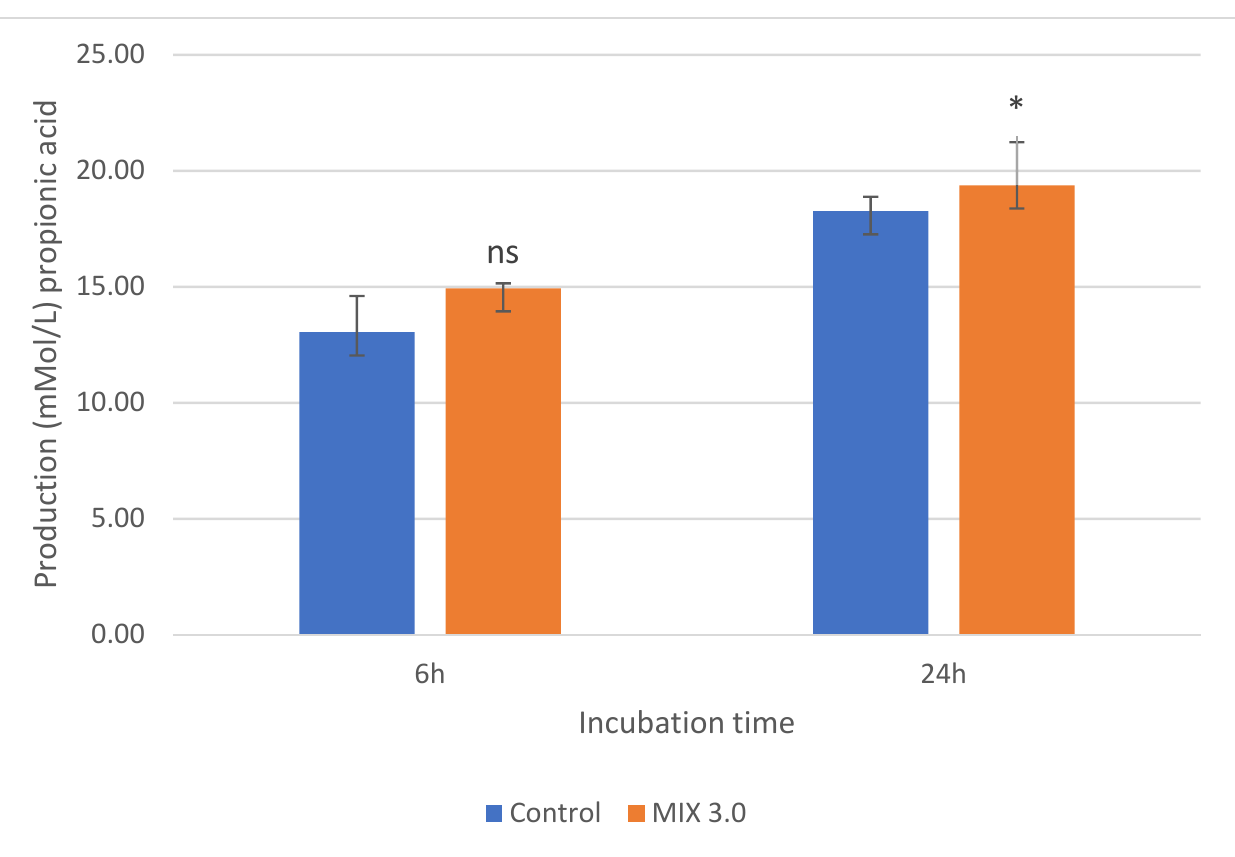
fluid with and without MIX 3.0. Abbreviations: ns: not significant; *: significant at p -value < 0.05.